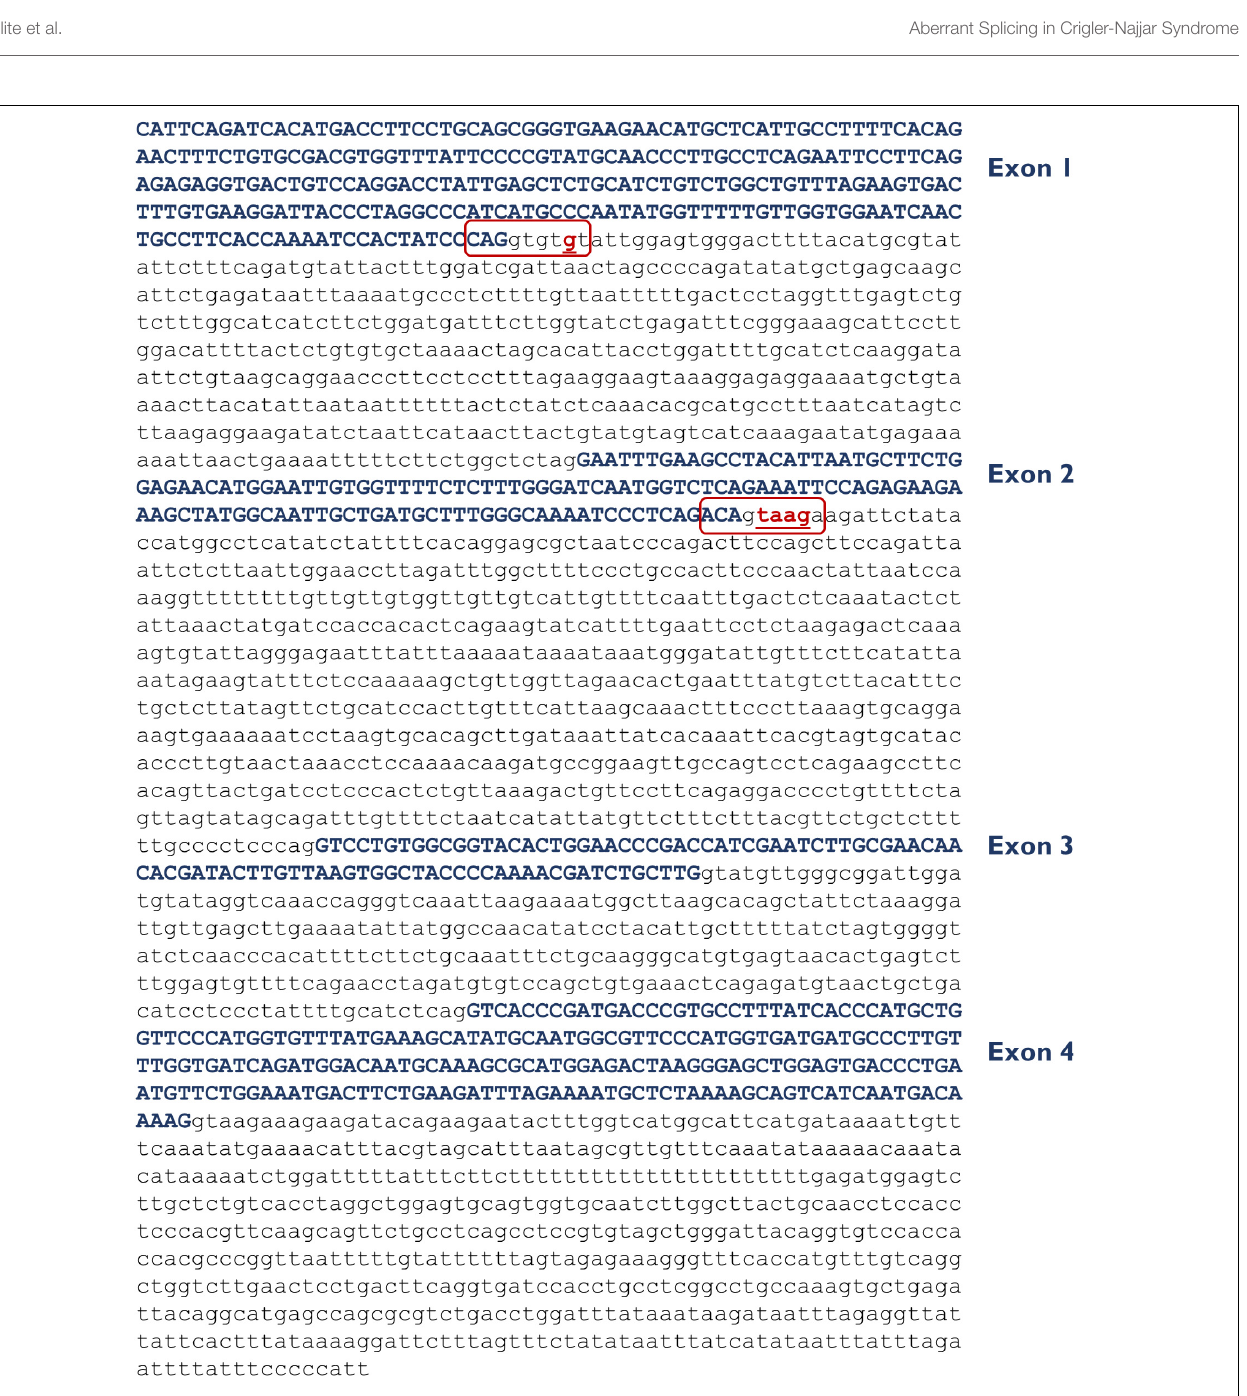
FIGURE 1 | Insert sequence (2,717 bp) of minigene mgUGT1A1_ex1-4. Exons are indicated in uppercase and variants c.864+5G > T (intron 1) and c.996+2_996+5del (intron 2) are shown in red and underlined. The donor splice sites of exons 1 and 2 are boxed.